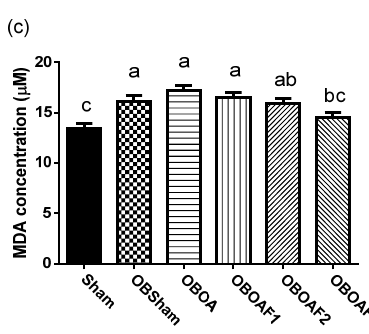
Figure 2. The effect of fucoidan treatment on the antioxidant activities in HFD ‐ induced obese male rats with ACLT + MMx surgery induced OA. ( a ) Superoxide dismutase, SOD. ( b ) Glutathione peroxidase, GPx. ( c ) Malondialdehyde, MDA. The data are the activity of each enzyme and the concentration of the plasma reactive oxygen species, expressed as the mean ± S.E.M ( n = 7). The values with different superscript letters (a)–(c) represent significant differences ( p < 0.05) via one ‐ way ANOVA followed by Duncan’s multiple range test.